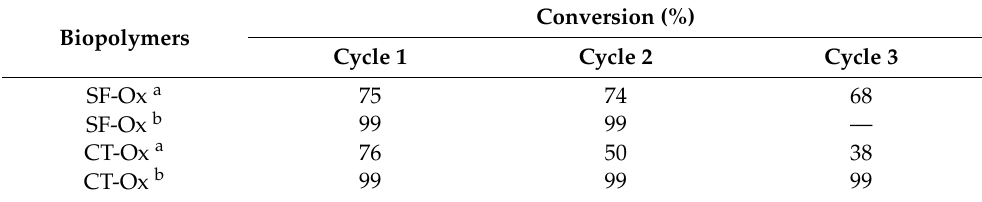
Table 2. Reuse of SF-Ox and CT-Ox in the formation reaction of adduct 2a . Conversion (%) Biopolymers Cycle 1 Cycle 2 Cycle